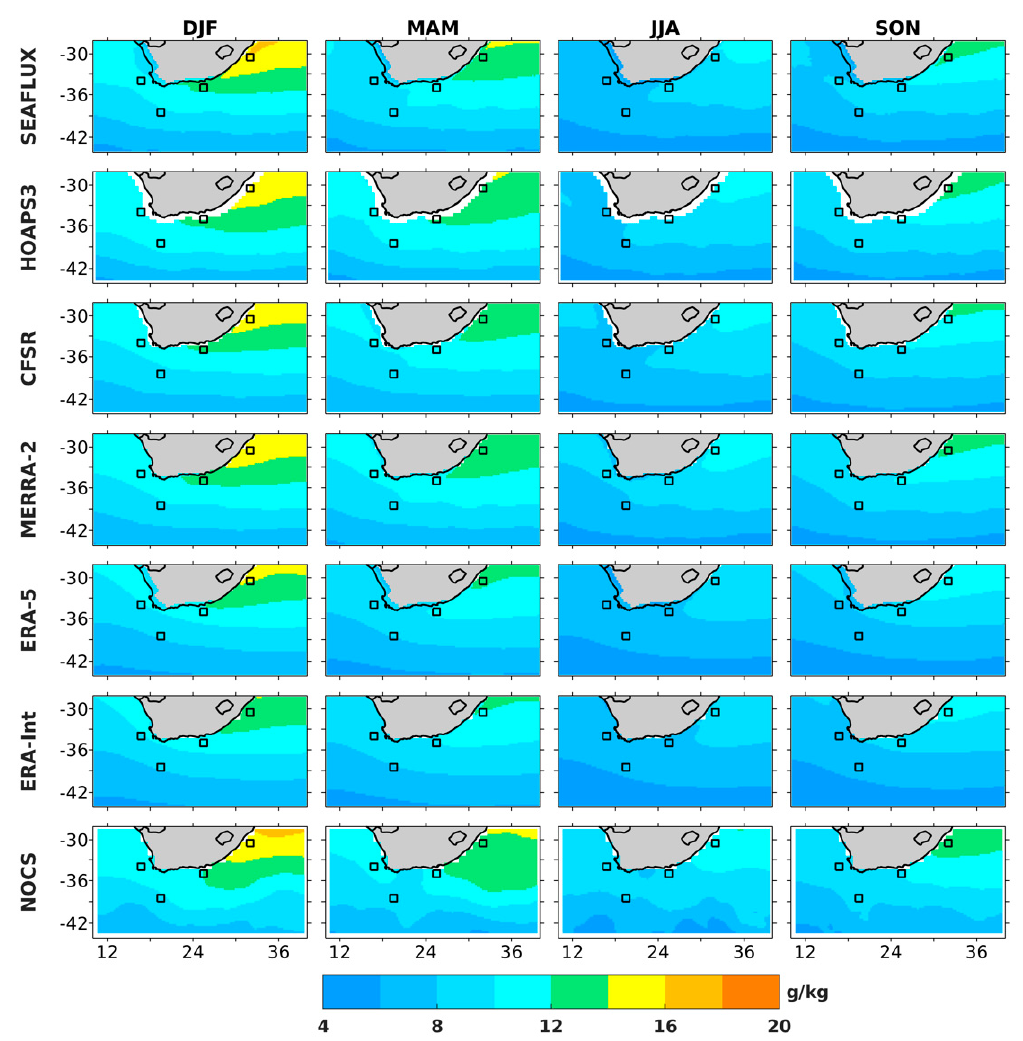
Figure 12 : Seasonal average of specific humidity of air (Qa, g/kg) of SEAFLUX, HOAPS3, CFSR, MERRA-2, ERA-Interim and NOCS. From left to right austral summer (DJF), austral autumn (MAM), austral winter (JJA) and austral spring (SON). Black squares represent the four locations of the study.